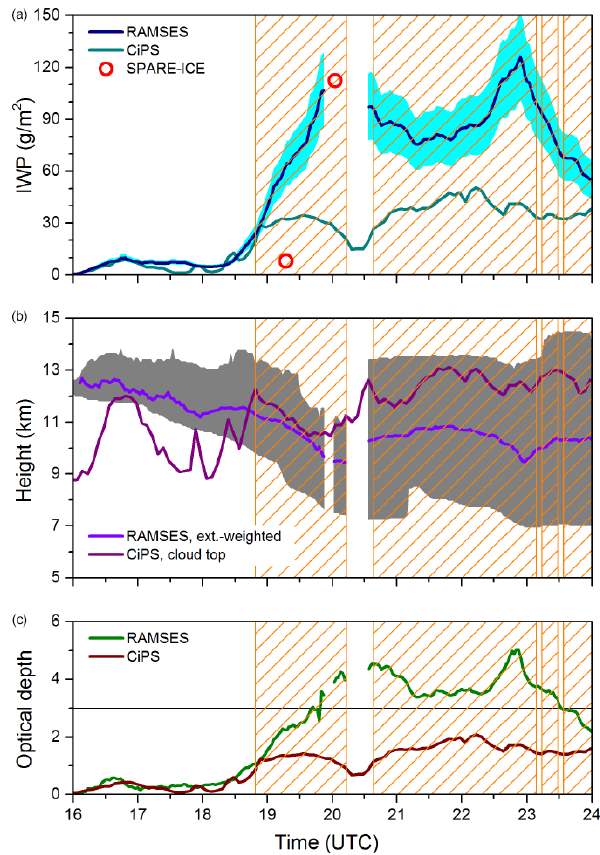
Figure A1. Cirrus temporal evolution as retrieved from the RAM- SES and satellite observations after 16:00UTC on 4 July 2015. (a) IWP, with error estimates of the RAMSES retrieval provided (cyan-shaded area). Orange-hatched bars indicate time periods for which CiPS IWP is flagged as compromised by an optical depth that is too high. (b) Cloud vertical extent (grey-shaded area) and extinction-weighted cloud height, as measured with RAMSES, and CiPS CTH. (c) Optical depth. RAMSES data are corrected for mul- tiple scattering. The CiPS threshold optical depth is indicated (hor- izontal